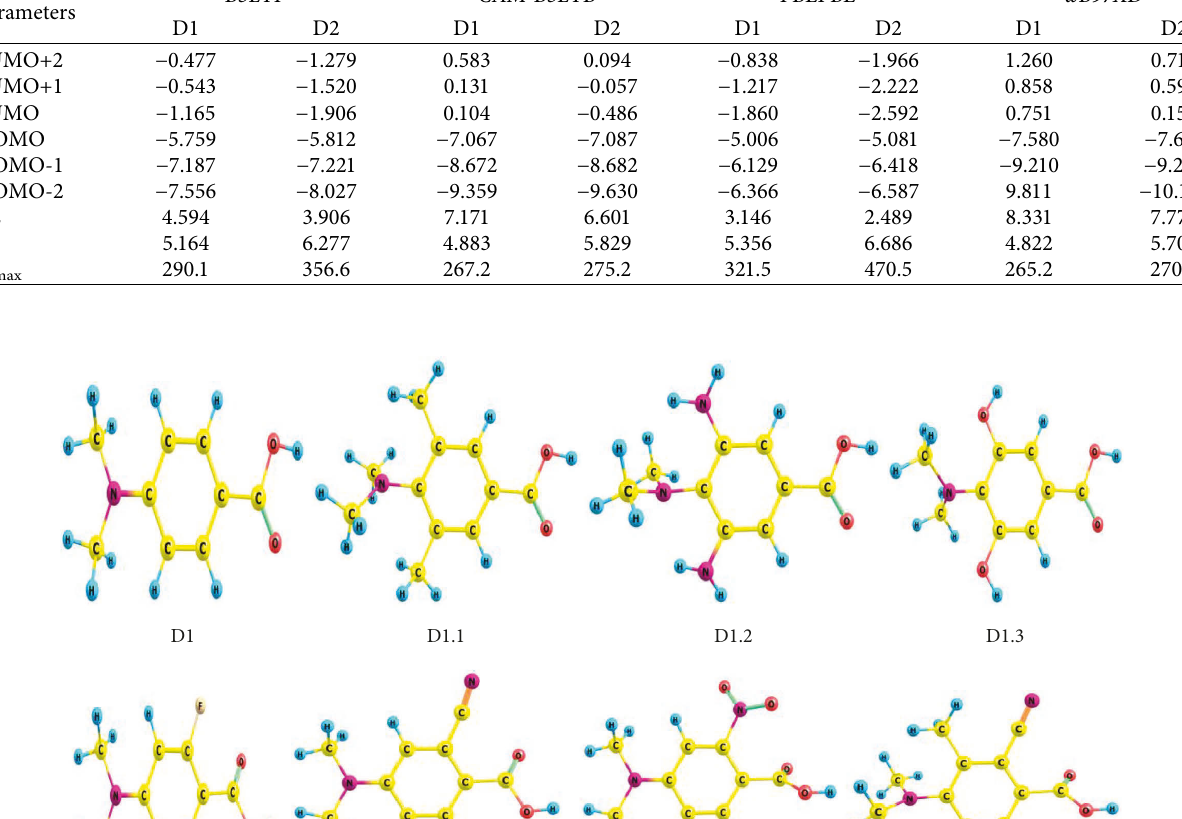
max /nm) of the gas-phase neat